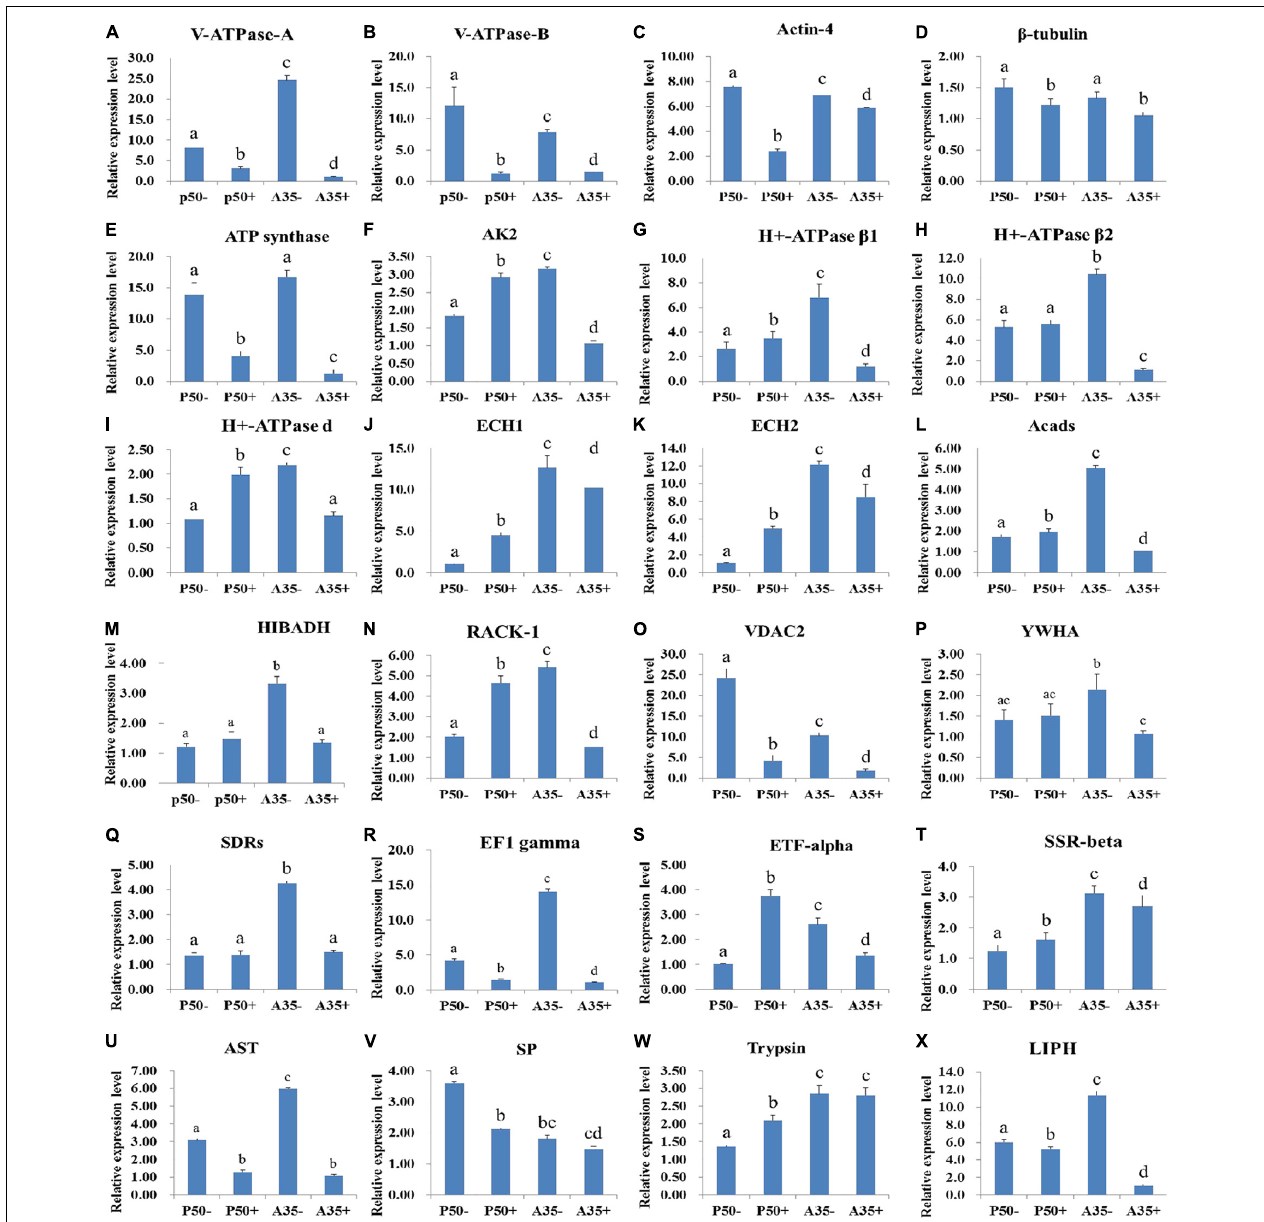
FIGURE 9 | RT-qPCR analysis of the expression profiles of the BmNPV interacting proteins in different resistant silkworm midguts. (A–X) represents the transcription level of 24 BmNPVinteracting proteins in different resistant silkworm strains following BmNPV infection. The data were normalized using BmGAPDH and presented as the means ± standard error of the means from three independent experiments. The relative expression levels were calculated using the 2 − (cid:49)(cid:49) Ct method. The statistical analysis was conducted using SPSS software. Significant differences are indicated by letters ( P <